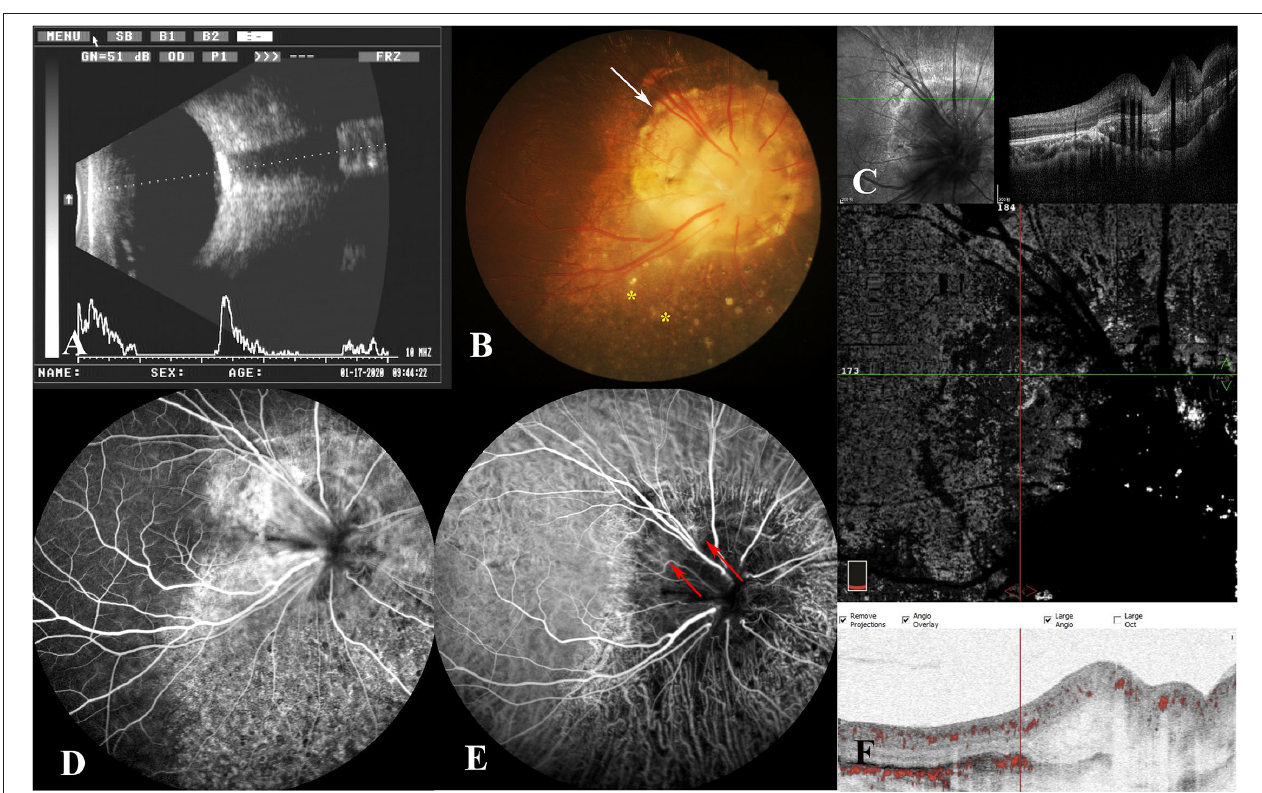
FIGURE 3 | (A) B-scan ultrasonography demonstrated a highly reflected mass covering the optic disc, and a high echo spike originating from the surface of the lesion was detected on the combined A-scan. (B) Fundus photography showed a yellowish-white lesion around the optic disc (white arrow) and mottling of the retinal pigment epithelium (RPE) (yellow stars). (C) On enhanced depth imaging OCT (EDI-OCT), a well-defined peripapillary choroidal lesion with hyperreflective lamellar lines in the inner part and spongiform pattern in the outer part were depicted. (D) The late phase of FA revealed diffuse late staining around the optic disc and punctate hypofluorescence inferiorly. (E) The indocyanine green angiography (ICGA) illustrated early hypofluorescence and diffuse late staining in the juxtapapillary area. In the early phase, the patterns of vessels were obtained supranasally to the optic disc (red arrow). (F) The blood flow signals were demonstrated among the lesion on OCT angiography